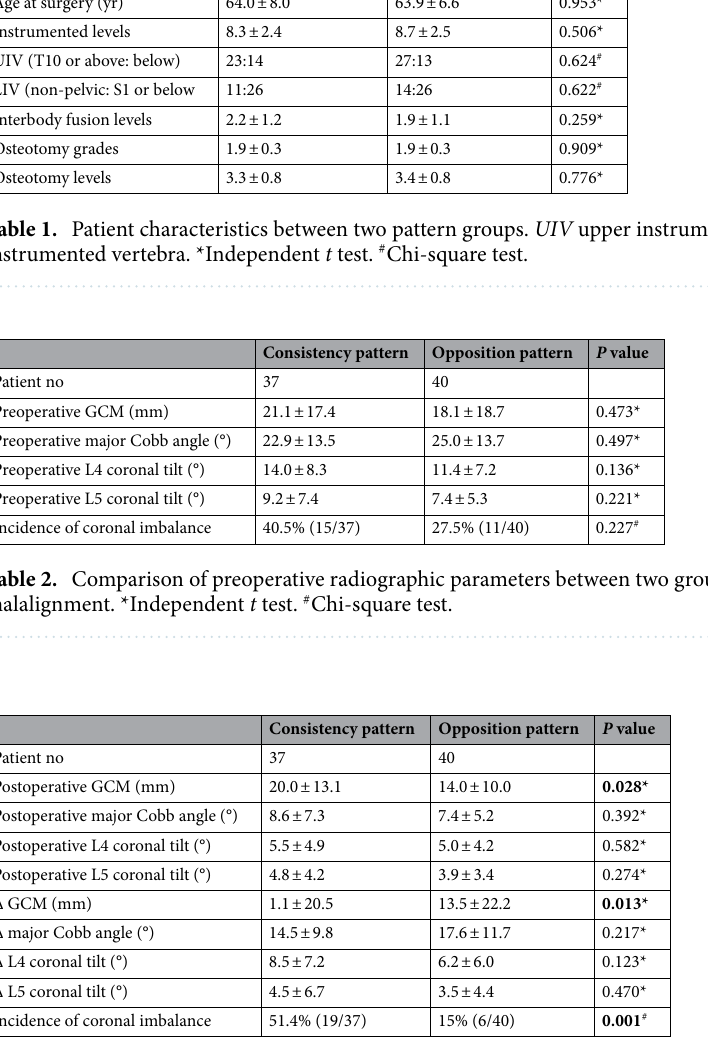
Table 3. Comparison of postoperative radiographic parameters and their changes between two groups. Boldface indicates statistical significance; GCM: global coronal malalignment. *Independent t test. # Chi square